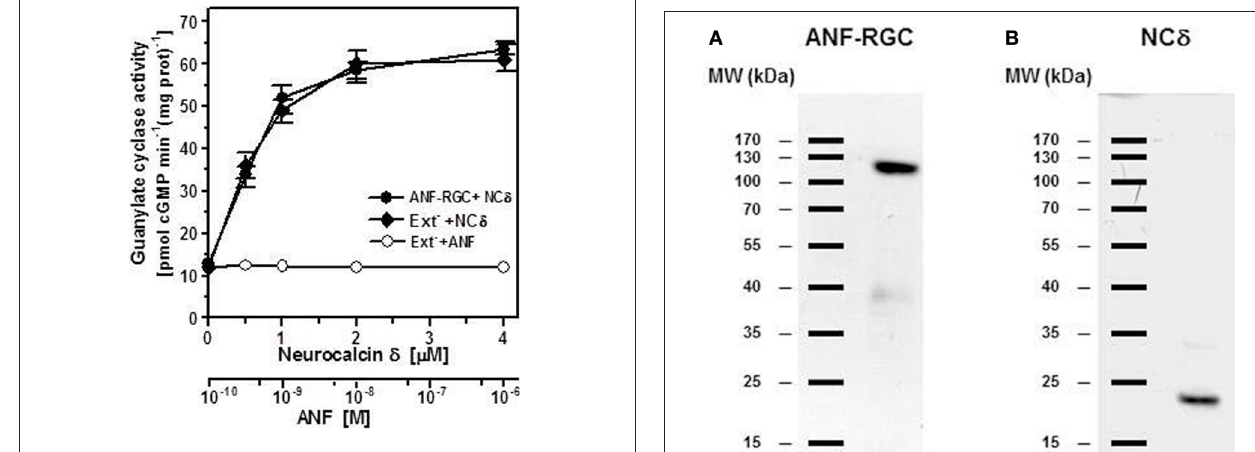
FIGURE 2 | The intracellular portion of ANF-RGC is sufficient for neurocalcin δ and Ca 2 + to stimulate ANF-RGC activity. The ANF-RGC deletion mutant lacking the extracellular receptor domain aa12–433, was constructed and expressed in COS cells. The particulate fraction of these cells was assayed for guanylate cyclase activity in the presence of increasing concentrations of myristoylated neurocalcin δ and 10 μ M Ca 2 + or 0.5mM ATP and increasing concentrations of ANF. Membranes of COS cells expressing full-length ANF-RGC were processed in parallel as positive control. The experiment was performed in triplicate and repeated two times. The results shown are mean ± SD from these experiments.